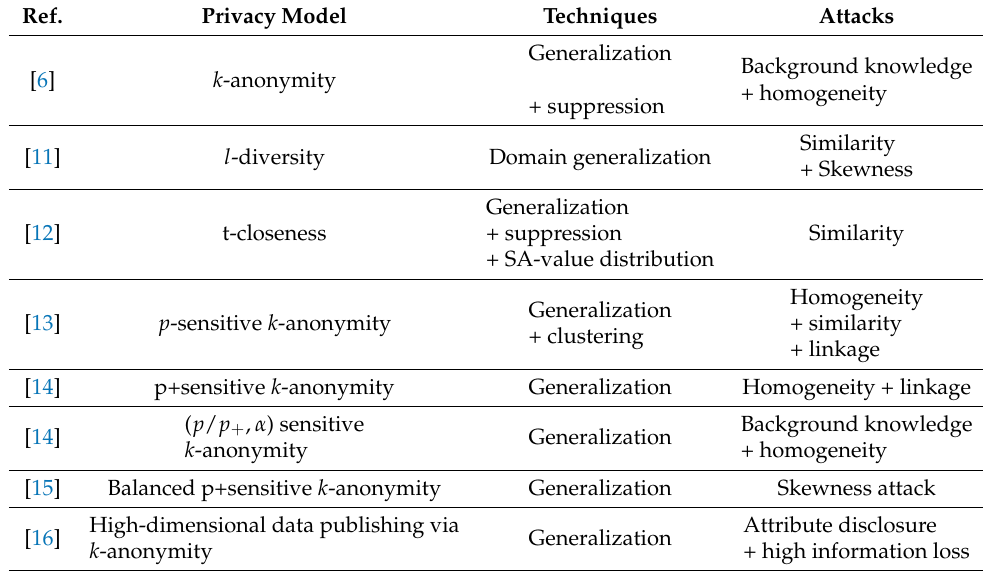
Table 1. An overview of previously proposed